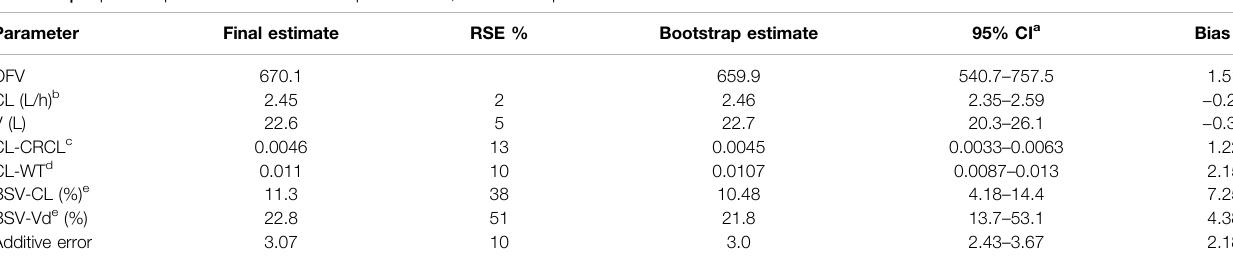
TABLE 2 | Population parameter estimates compared with 1,000 bootstrap estimates.